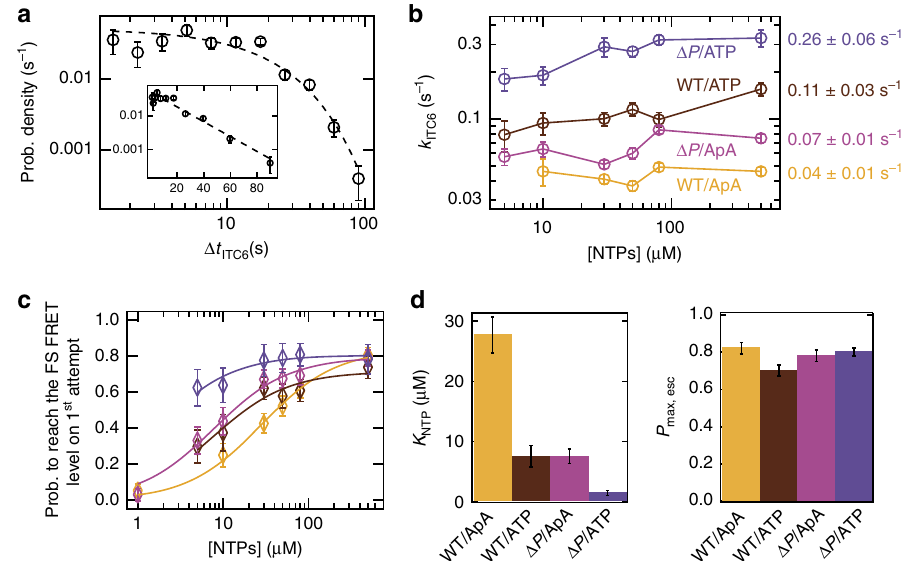
Fig. 2 The pause characteristics are a function of the downstream DNA promoter sequence at the + 6 position and of the 5 ′ -RNA end nature. a Probability density distribution for the Δ t ITC6 for the RP complexes behaving as in Fig. 1c. The dashed line is a single-exponential fi t from a MLE. Inset: Log-lin representation of the same data. Experimental conditions: 500 µ M ApA starting substrate, 80 µ M all NTPs. b Δ t ITC6 lifetime extracted from single exponential MLE fi t similar to a for different promoter/starting substrate conditions (as indicated in the panel), different NTP conditions, i.e., all NTPs for WT/ApA (yellow) and ITC11 (Supplementary Fig. 1a) for all others, and different NTP concentrations (Supplementary Table 1). In the ATP-initiated reactions, we did not use NTP concentration below 5 µ M to prevent potential misincorporations of ATP (used at 500 µ M for initiation purposes) 69 . On the right-hand side is indicated the mean ± SD of k ITC6 for each promoter/starting substrate condition. c Probability to reach the fully scrunched (FS) FRET level in a single attempt (Fig. 1c). The solid lines are fi ts to a binding isotherm of the form p NTP ð Þ ¼ P max ; esc ´ NTP ½ (cid:2) = ð NTP ½ (cid:2) þ K NTP Þ . The error bars are 95% con fi dence intervals. d K NTP and P max,esc extracted from c . Error bars are 1 SD extracted from the fi